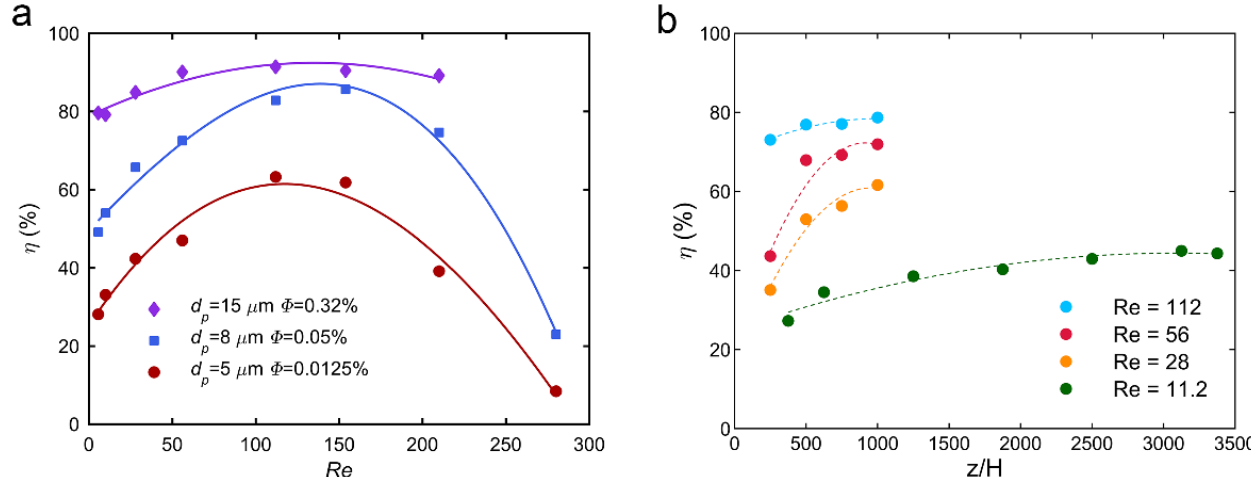
Figure 3. ( a ) Focusing degree η at z / H = 1000 from channel inlet and Φ = 0.05% with respect to Re , for a different particle to channel size ratios d p / H . ( b ) Focusing degree η for a particle to channel size ratio d p / H = 0.11 ( d p = 8.44 µ m) and Φ = 0.05% with respect to the dimensionless distance from the channel inlet z / H for different Reynolds numbers.